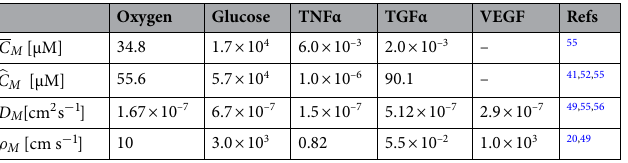
Table 1. Summary of select multiscale computational model parameters and value assignments using during simulation.